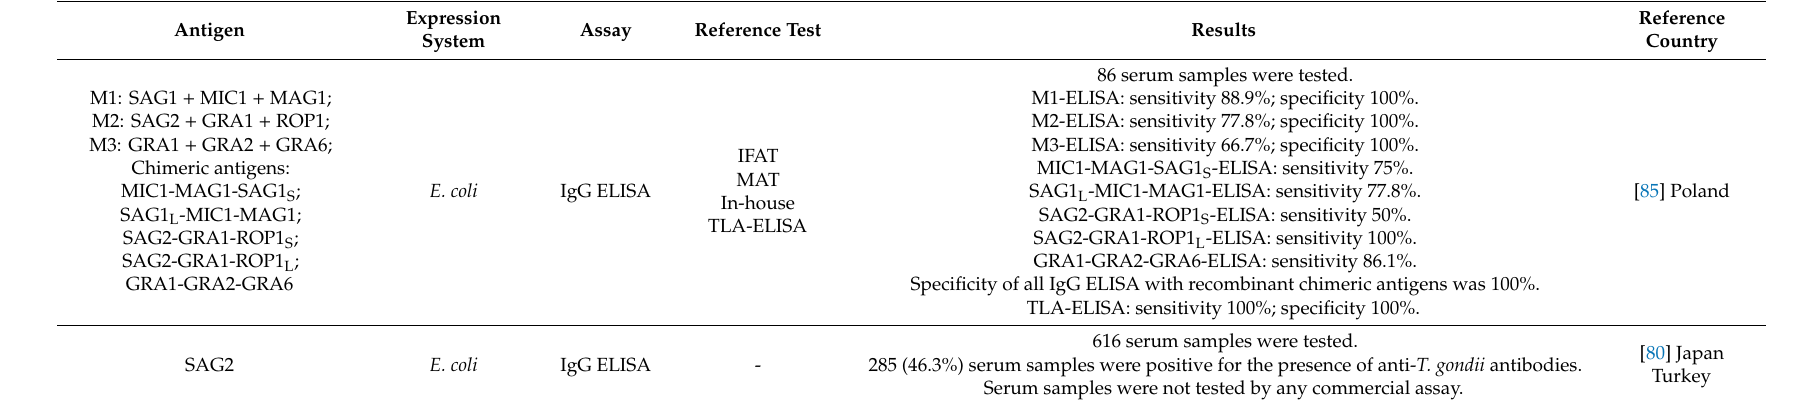
Table 8. Recombinant antigens used in detection of anti -T. gondii antibodies in equine serum samples.